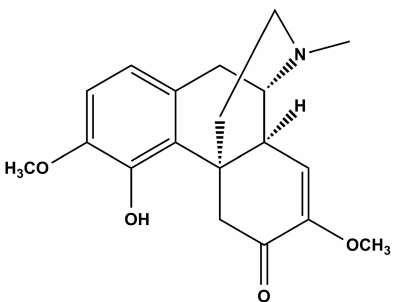
Figure 1. Chemical structure of